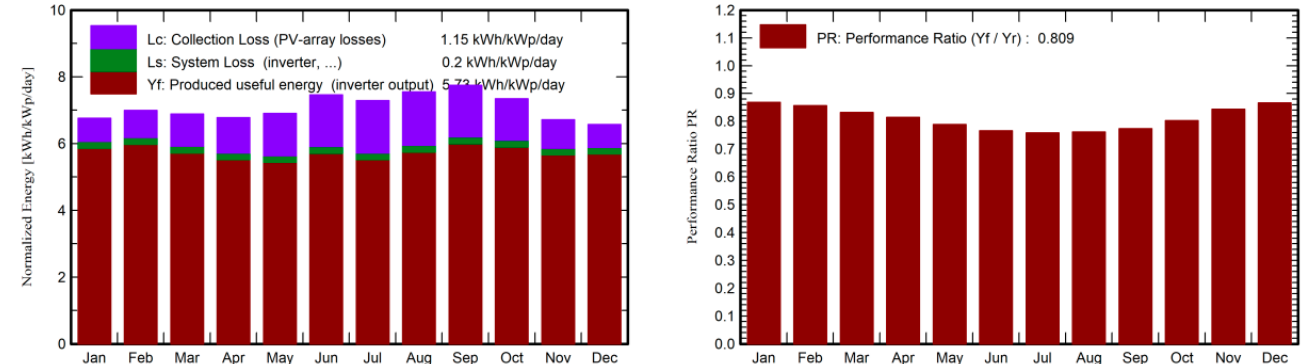
Figure 5. Normalized production and performance ratio for the Meybod area.